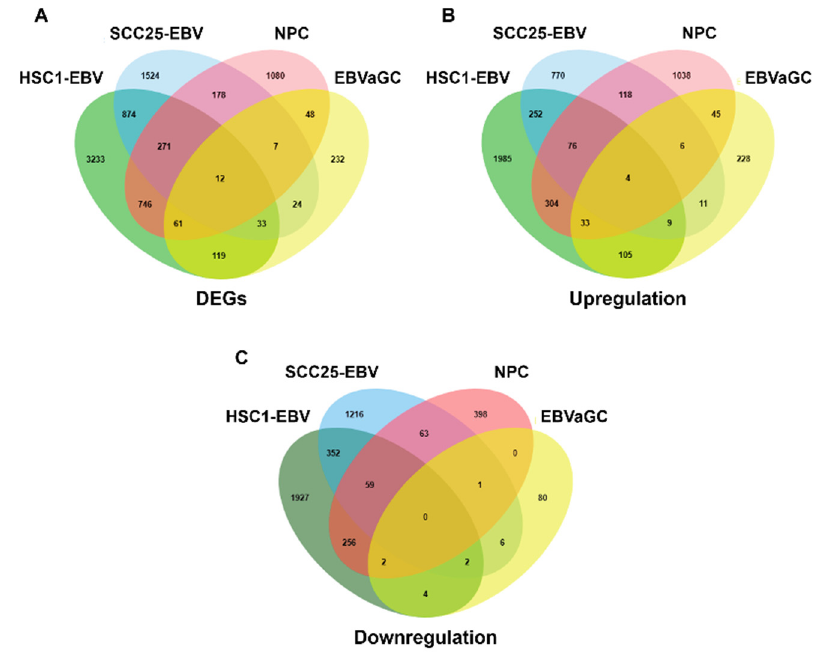
Figure 3. Differential expression of genes between EBV-infected OSCC, NPC, and GC cells. The Venn diagrams represent the DEGs ( A ), upregulated DEGs ( B ), and downregulated DEGs ( C ) in EBV-infected OSCC, NPC, and GC cells.